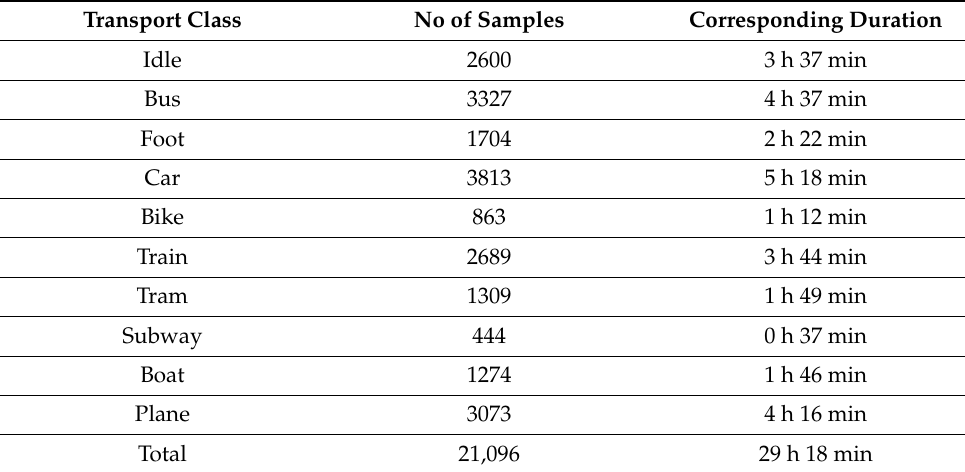
Table 1. Breakdown of collected transport data and corresponding